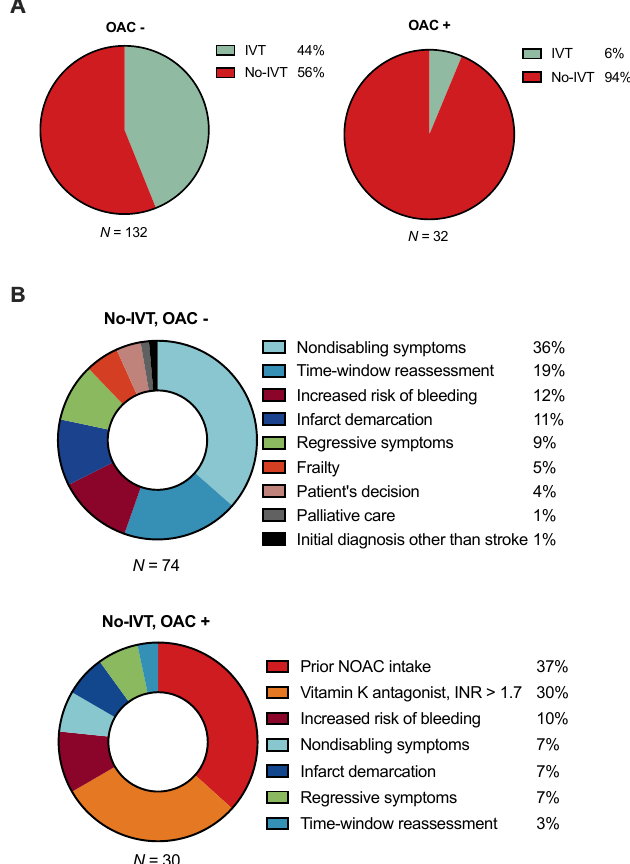
Figure 2. ( A ) Relative proportion of patients with ischemic stroke presenting within the 4.5-h time window receiving intravenous thrombolysis (IVT) with and without prior oral anticoagulation (OAC) who were considered eligible in first teleneurological assessment. ( B ) Reasons for not performing IVT in patients with and without OAC. NOAC, non-vitamin K antagonist oral anticoagulant. Increased risk of bleeding includes prior ICH ( n = 3), esophageal varices, active lung cancer with active bleeding, gastrointestinal ulcer, recent spinal infiltration, hemorrhagic transformation, recent GI bleeding, and acute fracture (all n = 1). Percentages do not round up to exactly 100% due to